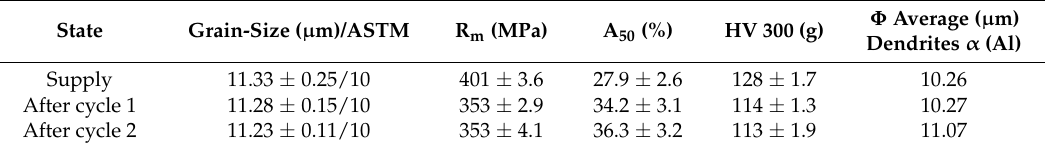
Figure 6. Stress–strain curve: DX51D supply (g); DX51D after cycle 1 (h); DX51D after cycle 2 (i). Table 3. ASTM grain-size, tensile strength (R m ), elongation of rupture (A 50 ), Vickers hardness (HV) of steel DX51D and average diameter ( µ m) of the micro-constituent dendrites α (Al) of the layer of Al-Si.